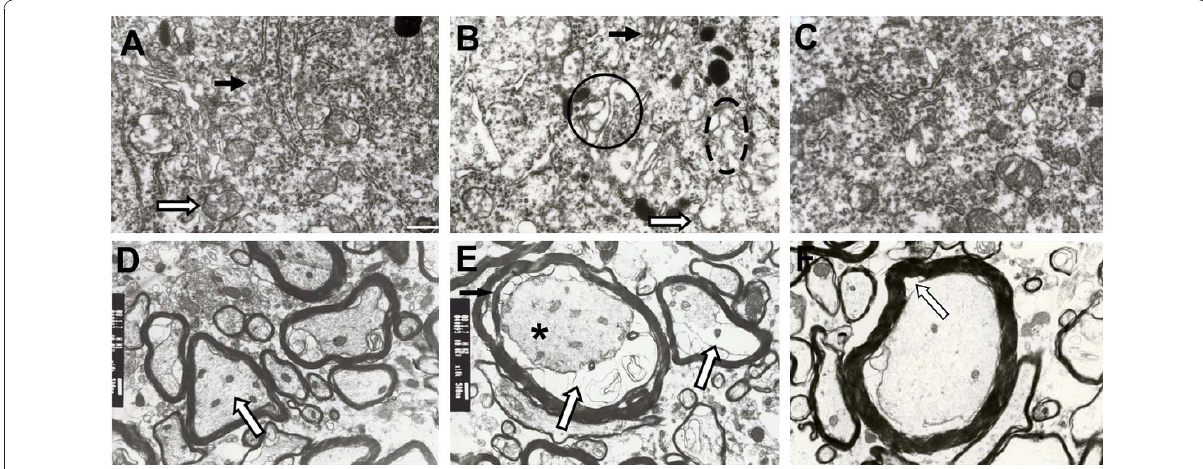
Figure 6 Electron micrographs showing the ultrastructural characteristics of NAm neurons in normal, DM, and DMC-treated DM rats . A: Electron micrograph of cytoplasm from a NAm neuron in a normal rat. The mitochondria (indicated by a hollow arrow) and endoplasmic reticulum (indicated by a solid arrow) are the predominant cytoplasmic organelles. B: Electron micrograph of the cytoplasm from a NAm neuron in a DM rat. The expanded endoplasmic reticulum is circled by a dashed line ellipse, the expanded Golgi body is circled by a solid line, and the partially lysed mitochondrion is indicated by a hollow arrow. C: Electron micrograph of the cytoplasm from a NAm neuron from a DMC-treated DM rat showing regular mitochondrial and endoplasmic reticulum structure. D: Electron micrograph of myelinated nerves from the NAm in a normal rat. Microtubules, microfilaments, and neurofilaments are visible in the medullary sheath and the membranes of myelinated nerves are attached tightly to the inner wall of the medullary sheath. E: Electron micrograph of myelinated nerves from the NAm in a DM rat. Axons appear to detach from the myelin sheath, yielding enlarged paces between the axolemma and medullary sheaths (hollow arrows). Decreased electron density indicates partial dissolution of the axoplasm (* symbol). F: Electron micrograph of myelinated nerves from the NAm a DMC-treated DM rat showing a reduction in the spaces between the axolemma and medullary sheaths (indicated by hollow arrow). Scale bar: 1.0 μ